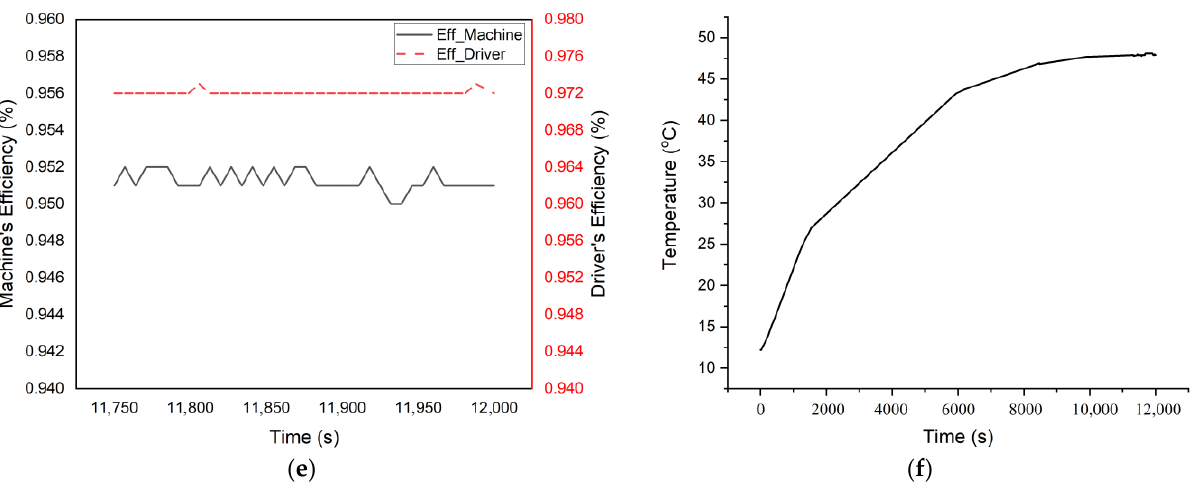
Figure 8. Test results: ( a ) Current and Voltage of Phase A; ( b ) Input and output powers; ( c ) Power factor of the machine; ( d ) Output torque; ( e ) Efficiencies; ( f ) Temperature of the machine.